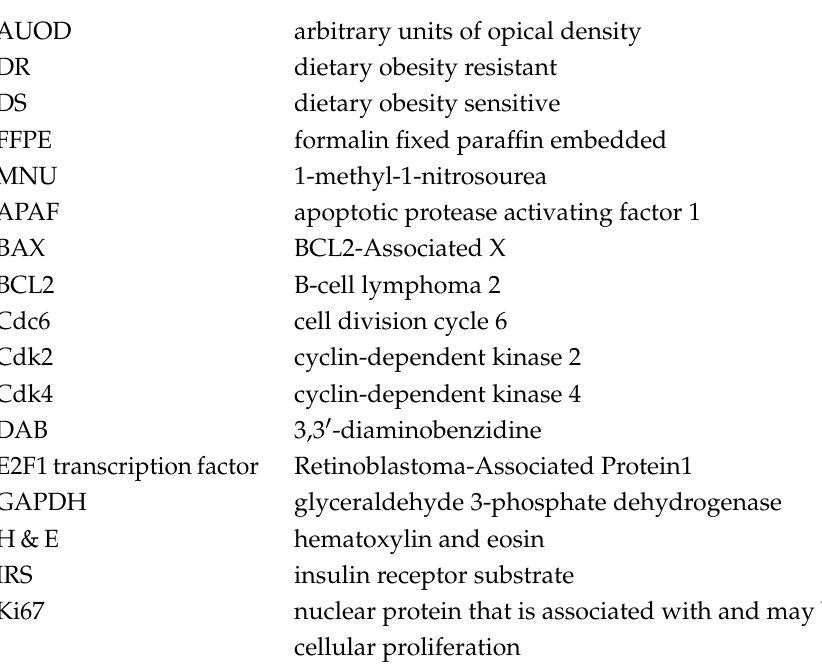
Figure S1: Effects on cell cycle machinery, Figure S2: Results of OPLS